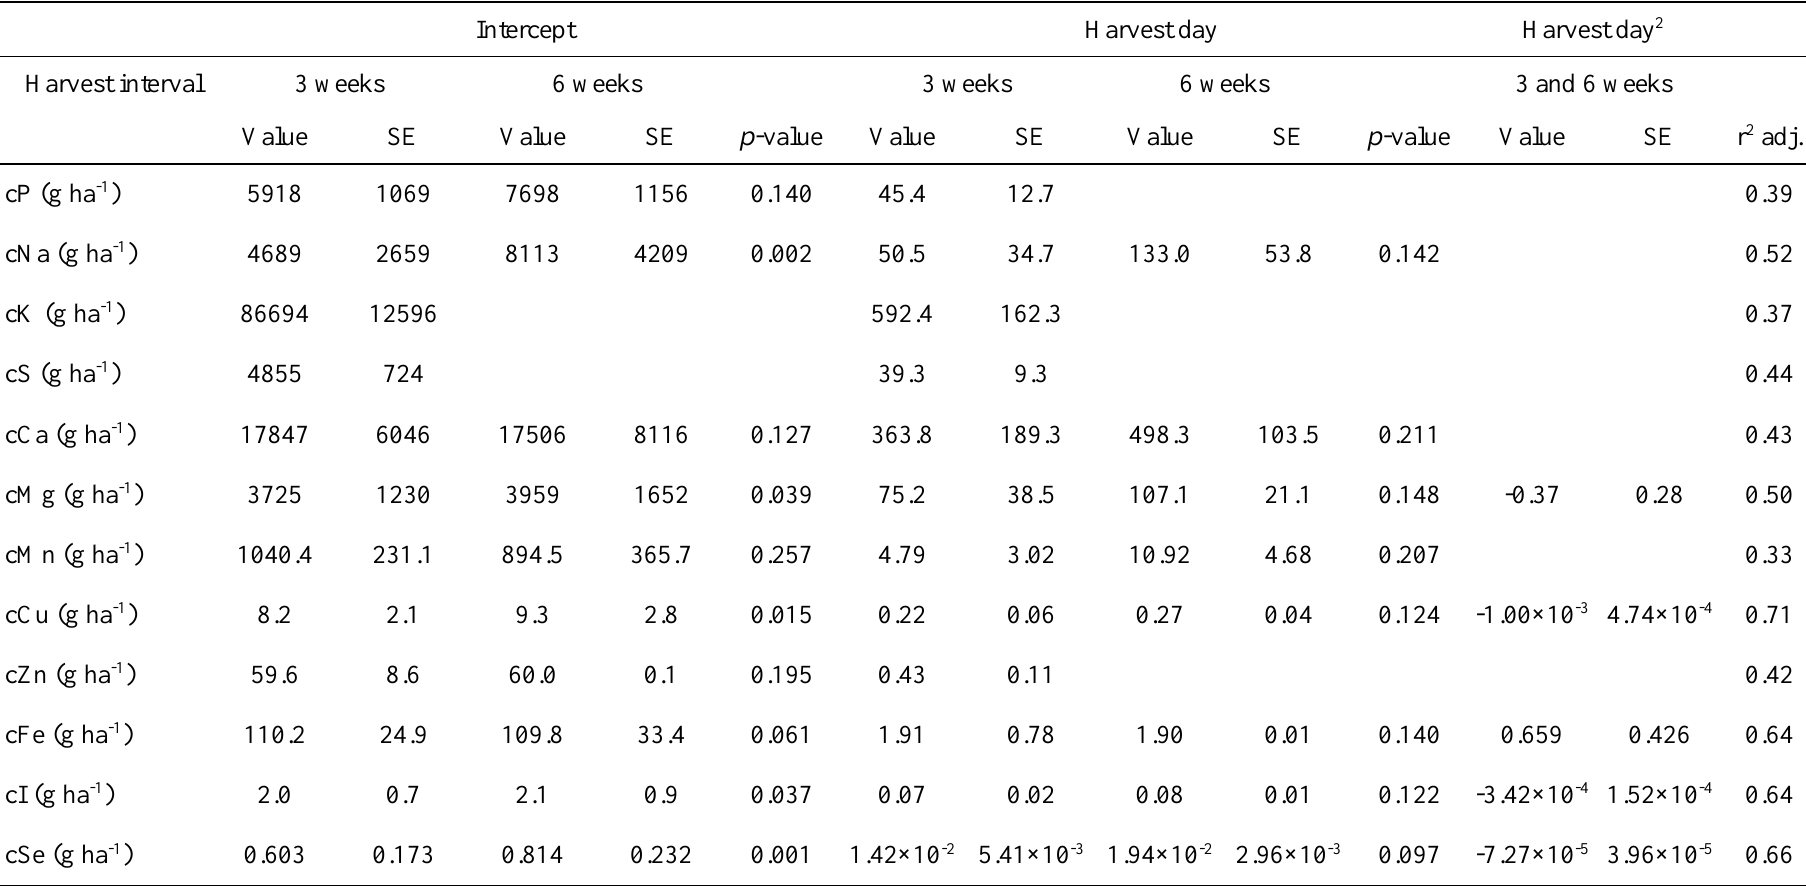
Table 7. Experiment III: Effect of harvest interval (3 weeks or 6 weeks) on cumulative (c) mineral yields of T. latifolia biomass one year after planting. Fitted parameters (3-week or 6-week interval) and harvest day the number of days after the first harvest on 19 May 2017. SE = standard